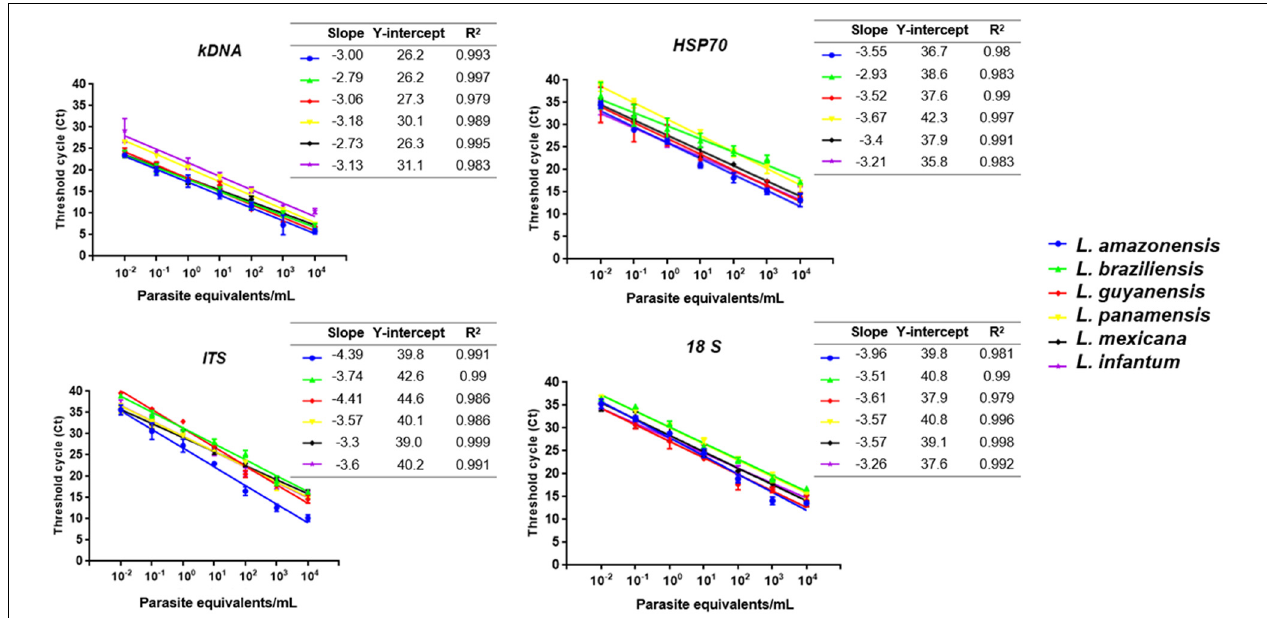
FIGURE 2 | Linear regression results for each of the four molecular marker employed with its respective Leishmania species including (i) the slope of the linear logarithmic phase of the reaction, representing the accuracy and reproducibility of the results (values between − 3.0 and − 3.6, with − 3.32 considered the expected value, corresponding to 100% efficiency), (ii) Y-intercept, corresponding to the theoretical detection limit of the reaction and (iii) correlation coefficient ( R 2